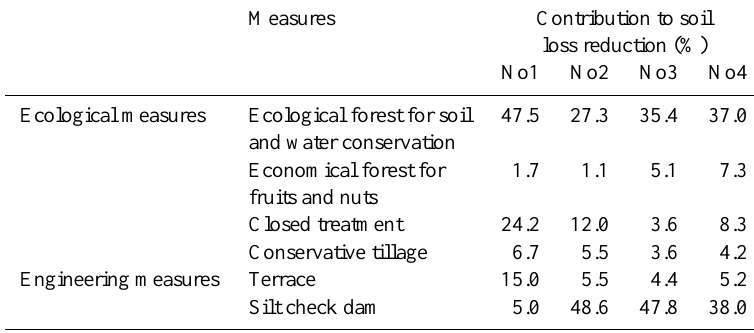
Table 8. The contribution of ecological and engineering measures to soil loss reduction at four plot sites (2000–2005).